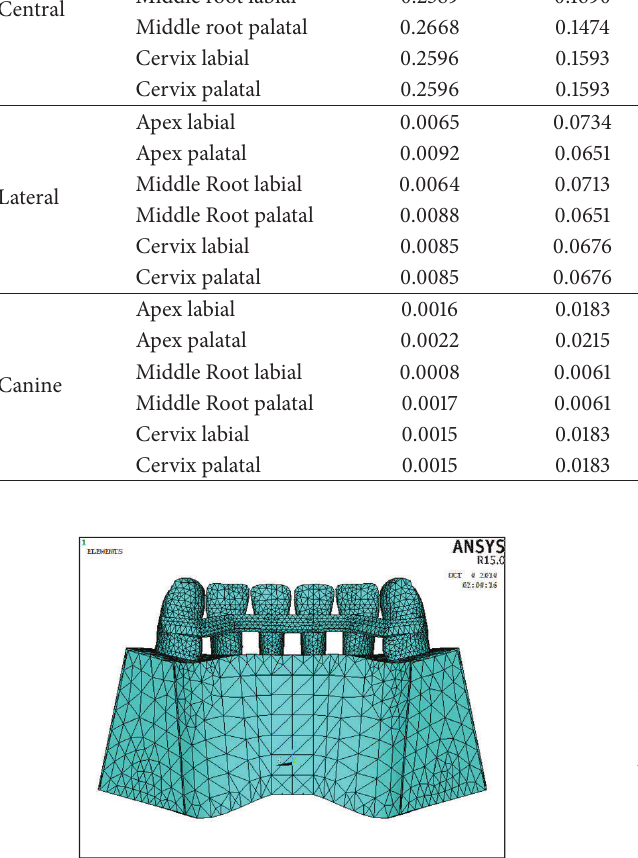
Figure 3: Model 3 in which FRC bonded to the middle third of lingual teeth